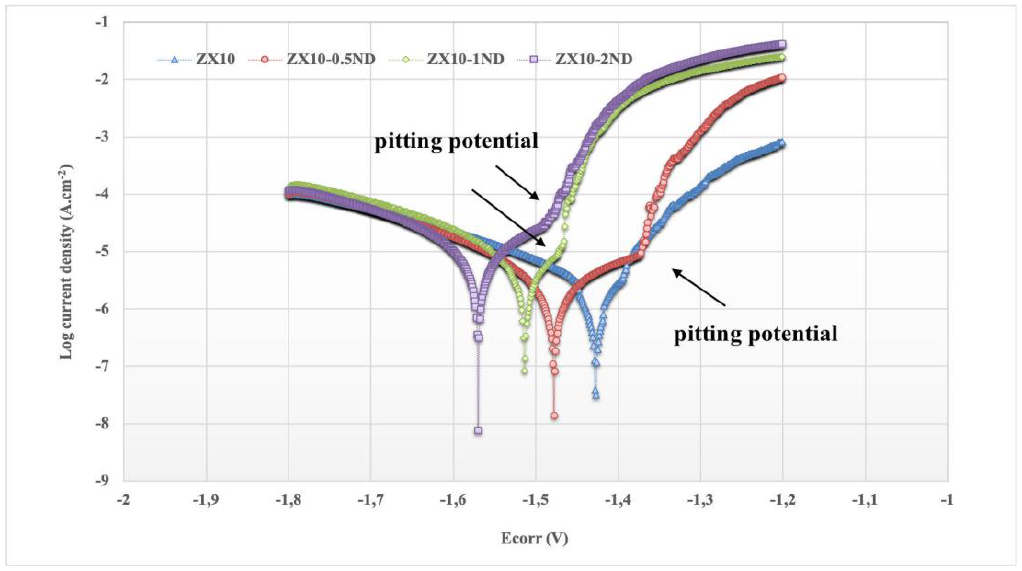
Figure 13. Potentiodyamic polarization curves of ZX10 alloy and nanocomposites in HBSS. Table 2. Electrochemical parameters and corrosion rates of samples in HBSS obtained by polariza- tion test.